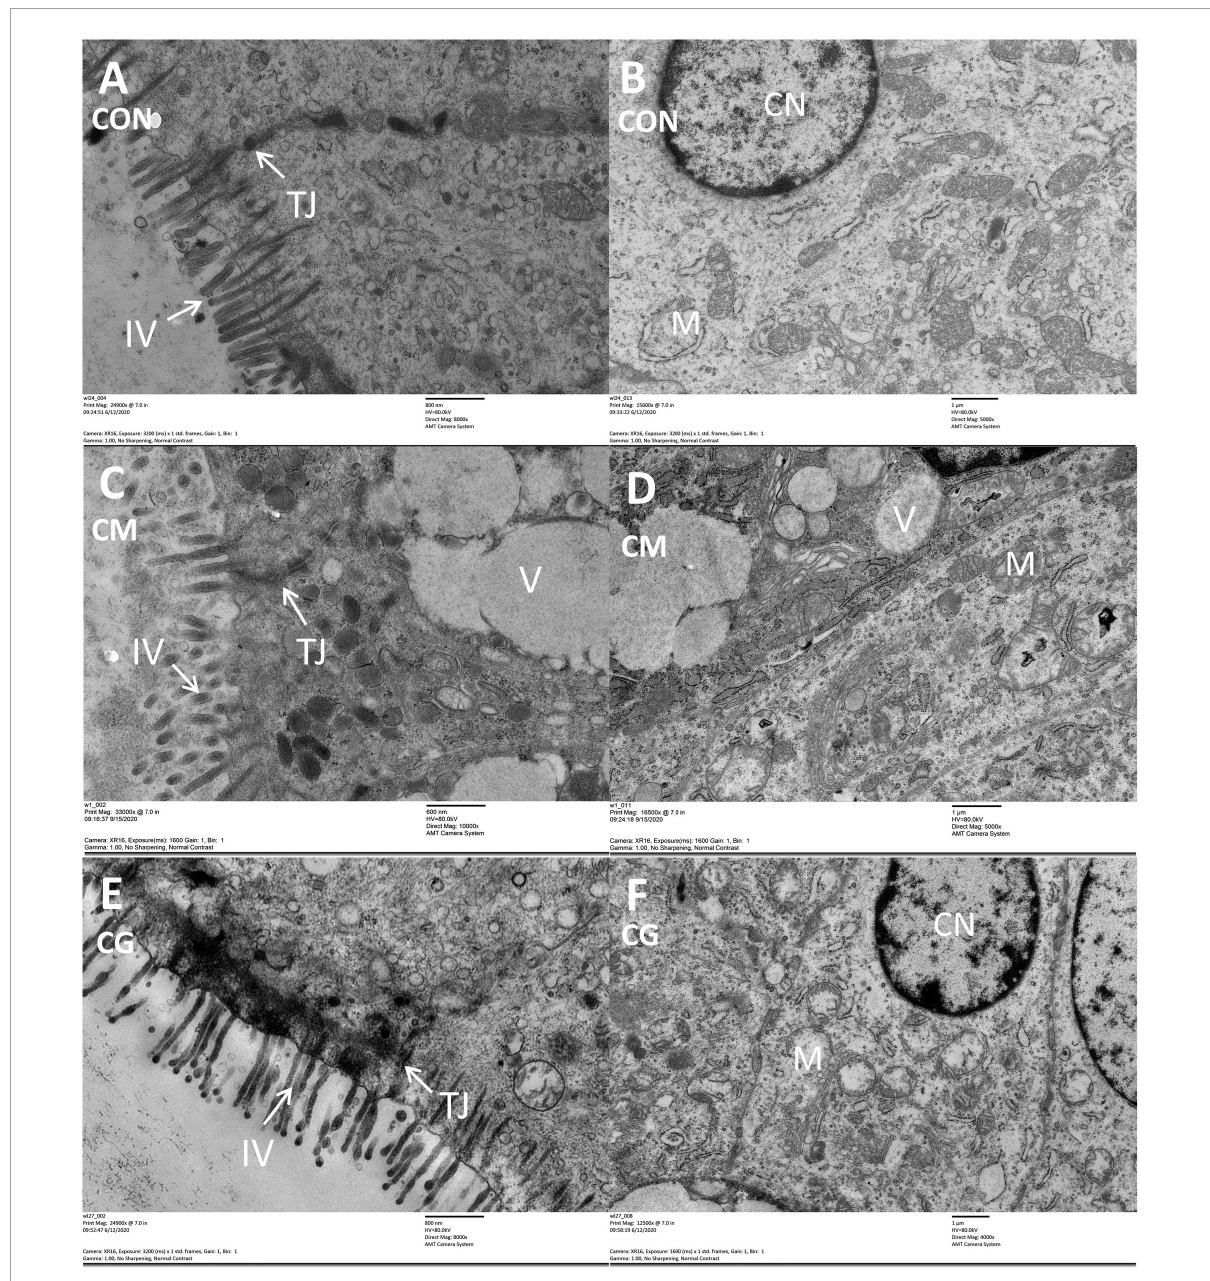
FIGURE1 The histology of colon tissue among low-grain fed (CON), maize meal high-grain fed (CM), and whole maize high-grain fed (CG) lambs. Comparison of colonic epithelial ultrastructure of junctional complexes among the CON [ (A) scale bar = 800 nm], CM [ (C) scale bar = 600 nm], and CG [ (E) scale bar = 800 nm]. The colonic epithelial ultrastructure in representative CON [ (B) scale bar = 1 µ m], CM [ (D) scale bar = 1 µ m], and CG [ (F) scale bar = 1 µ m]. TJ, tight junction; IV, intestinal villus; CN, cell nucleus; M, mitochondria; V, vacuole.